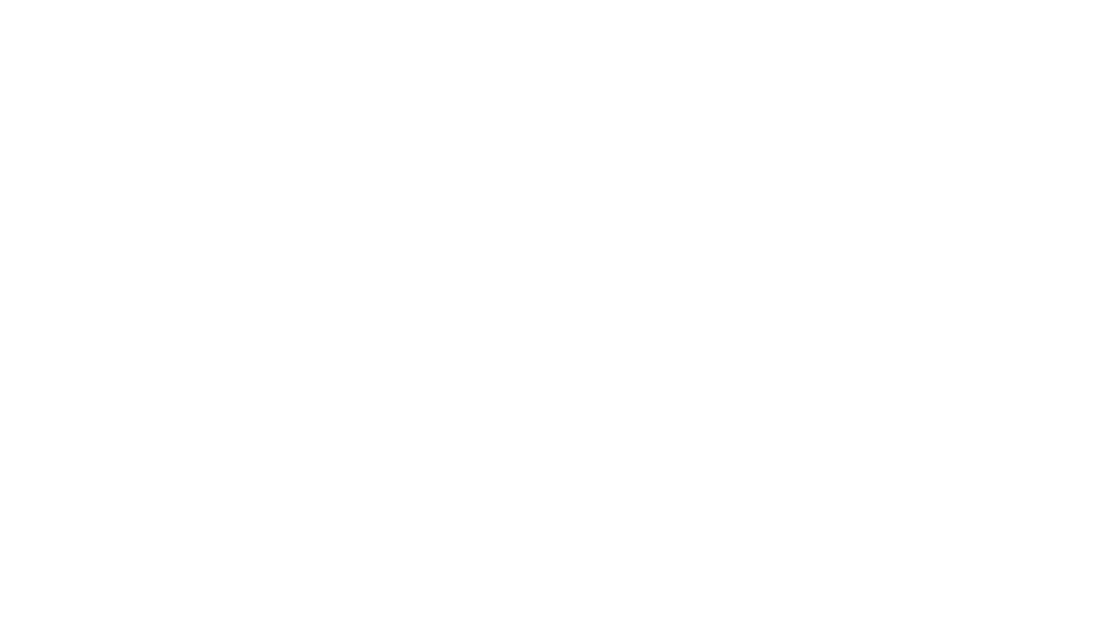
Figure 16. SEM and EDS analysis for oxide 800 °C after hot corrosion ( a ) surface morphology, ( b ) cross- section , ( c ) line element distribution, and ( d–g ) element map